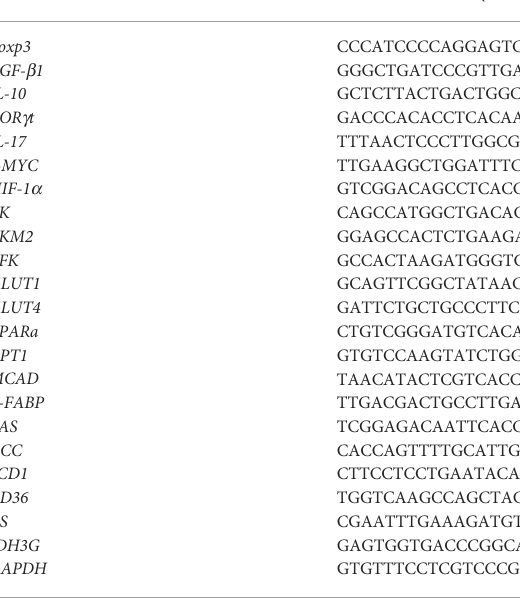
TABLE 1 Primer sequences of target mRNA.